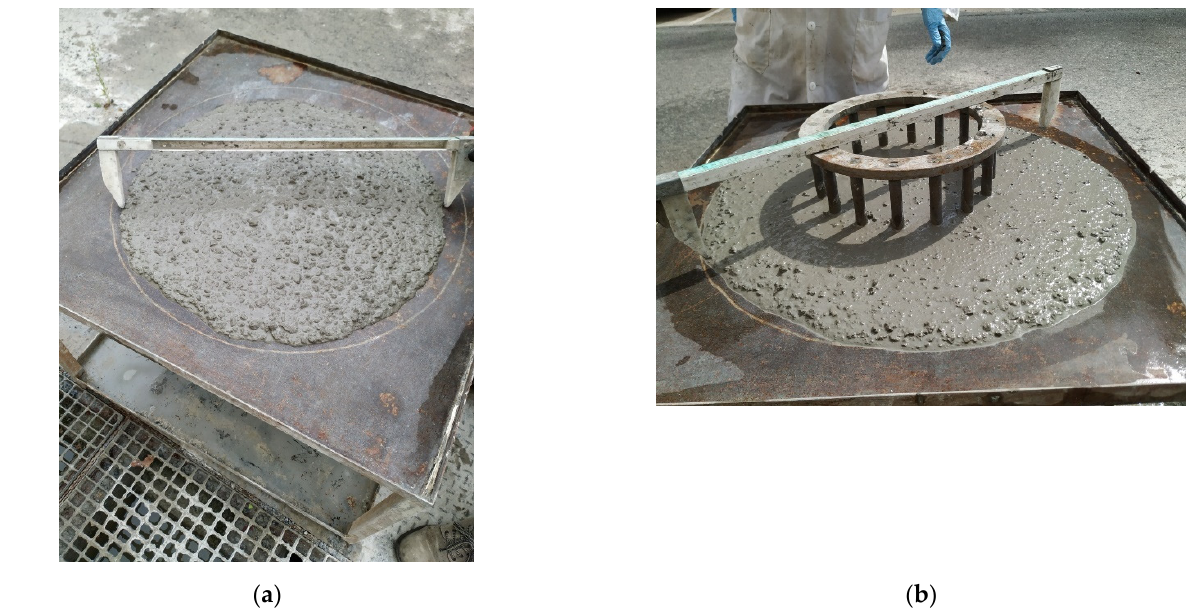
Figure 4. Results of the tests carried out according to the current regulations for considering self-compacting concrete (EHE-08). Slump flow ( a ) and J-Ring ( b ).